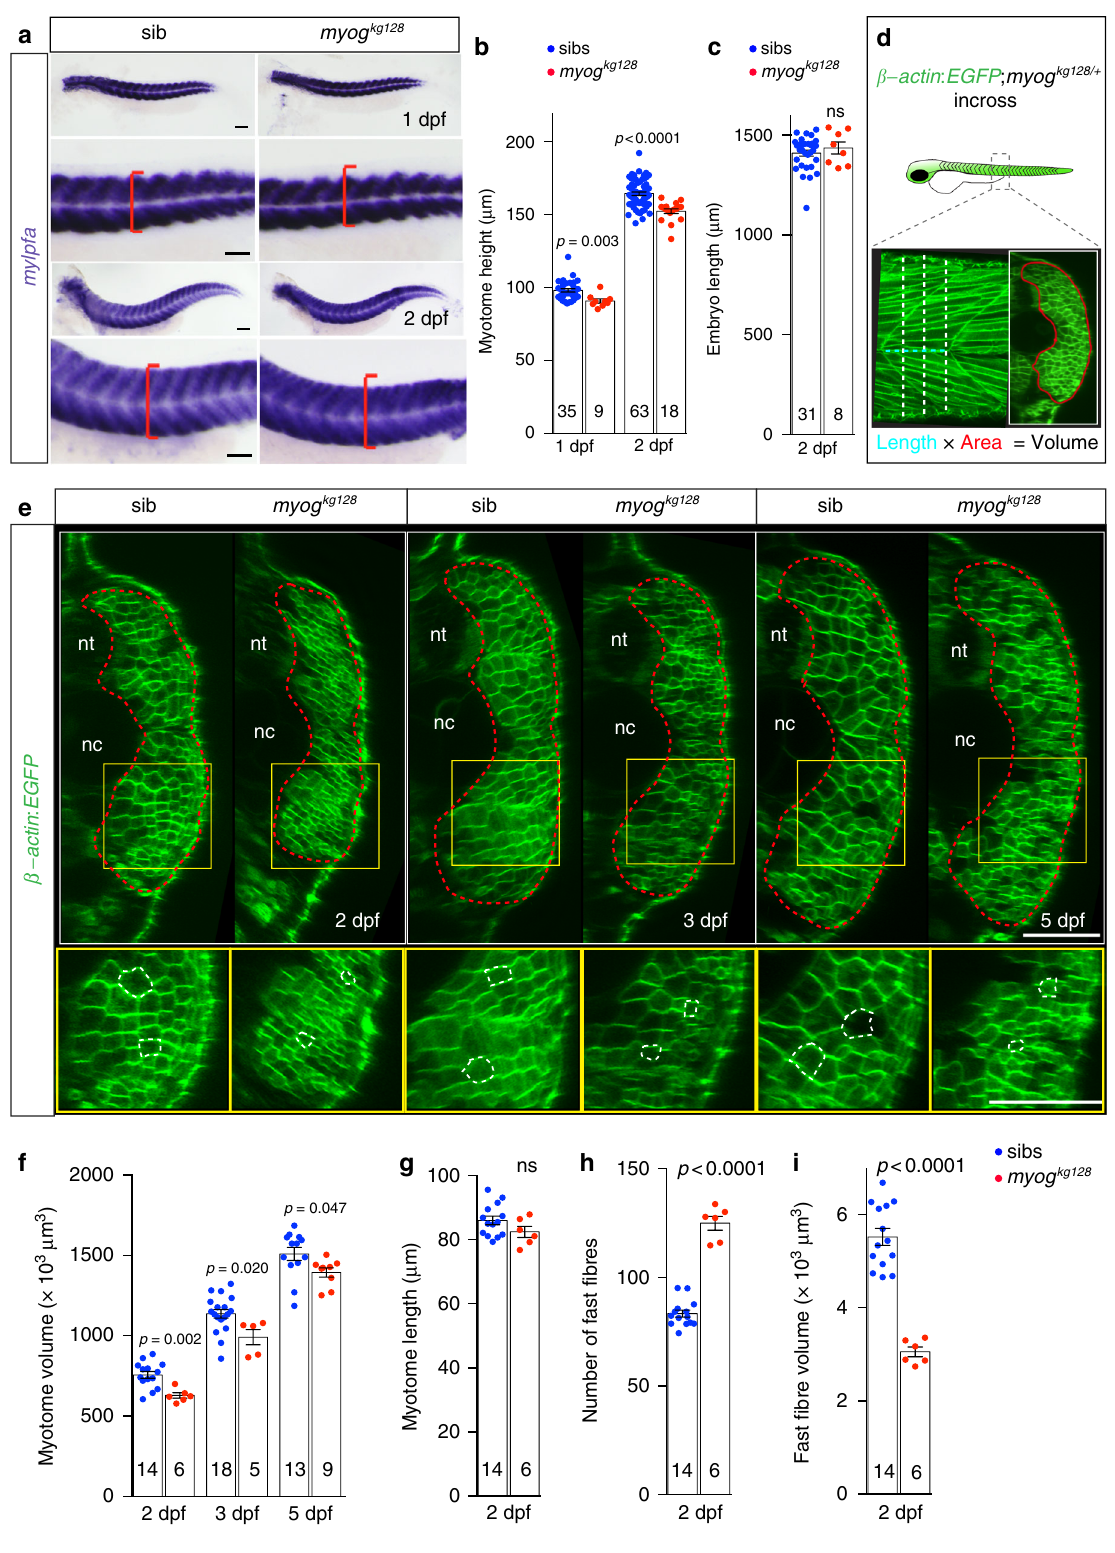
Adult myog mutants have small muscle with reduced fi bre size . Both putative null myog alleles are homozygous viable. By 4 months (120 dpf), compared to their co-reared sibs, adult mutants showed a reduction in standard weight, a measure that compensates for length changes (Fig. 7a, b; Supplementary Fig. 6a, b). In contrast, myog fh265 mutants were similar to sibs,